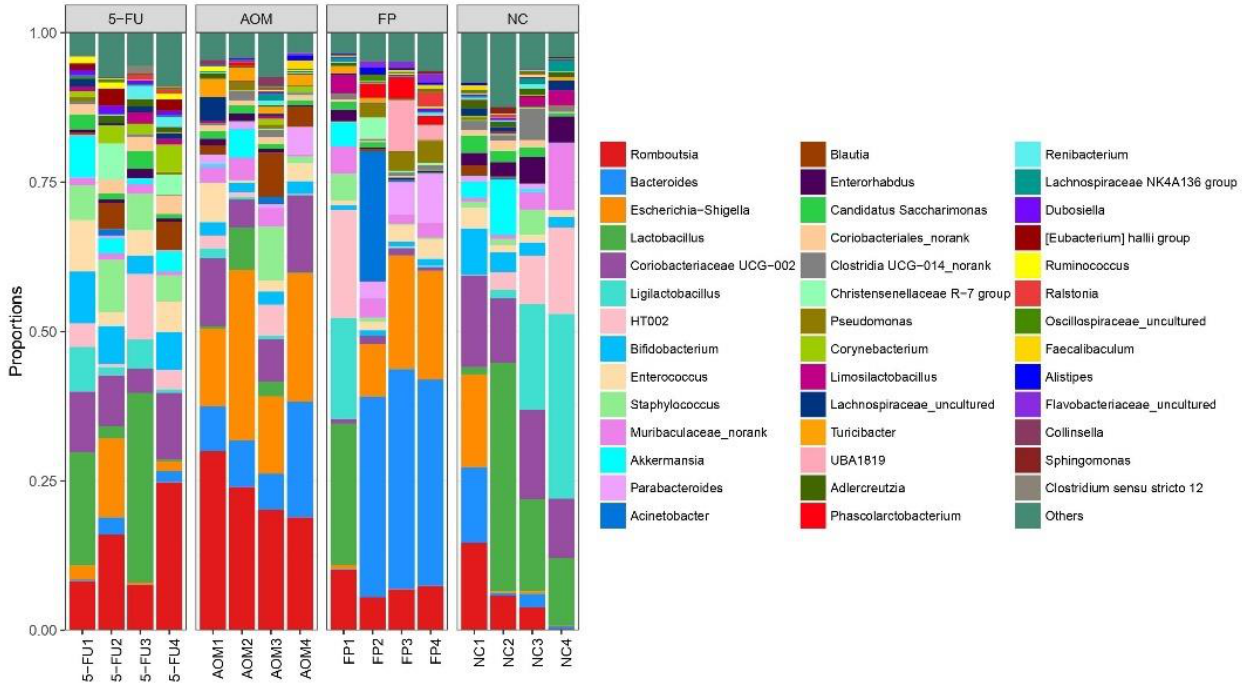
Figure 5. Plot of microbial diversity analysis at the genus level. (NC): Normal control group, (AOM): azoxymethane control group, (FP): F. prausnitzii group, (5FU): 5-fluorouracil group.